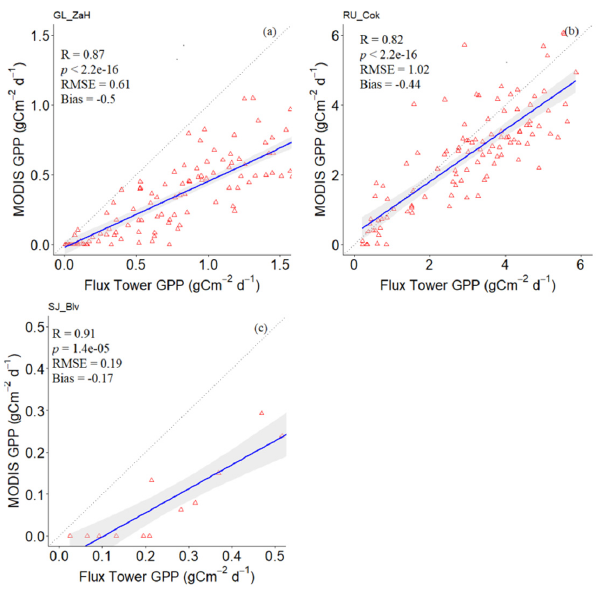
Figure 7. Scatter plots of site-based GPP against MOD17A2H over grasslands ( a ), shrublands ( b ), permanent snow and ice ( c ) sites. Flux tower GPP means in situ GPP. Gray belt refers to the confidence interval of 95%.